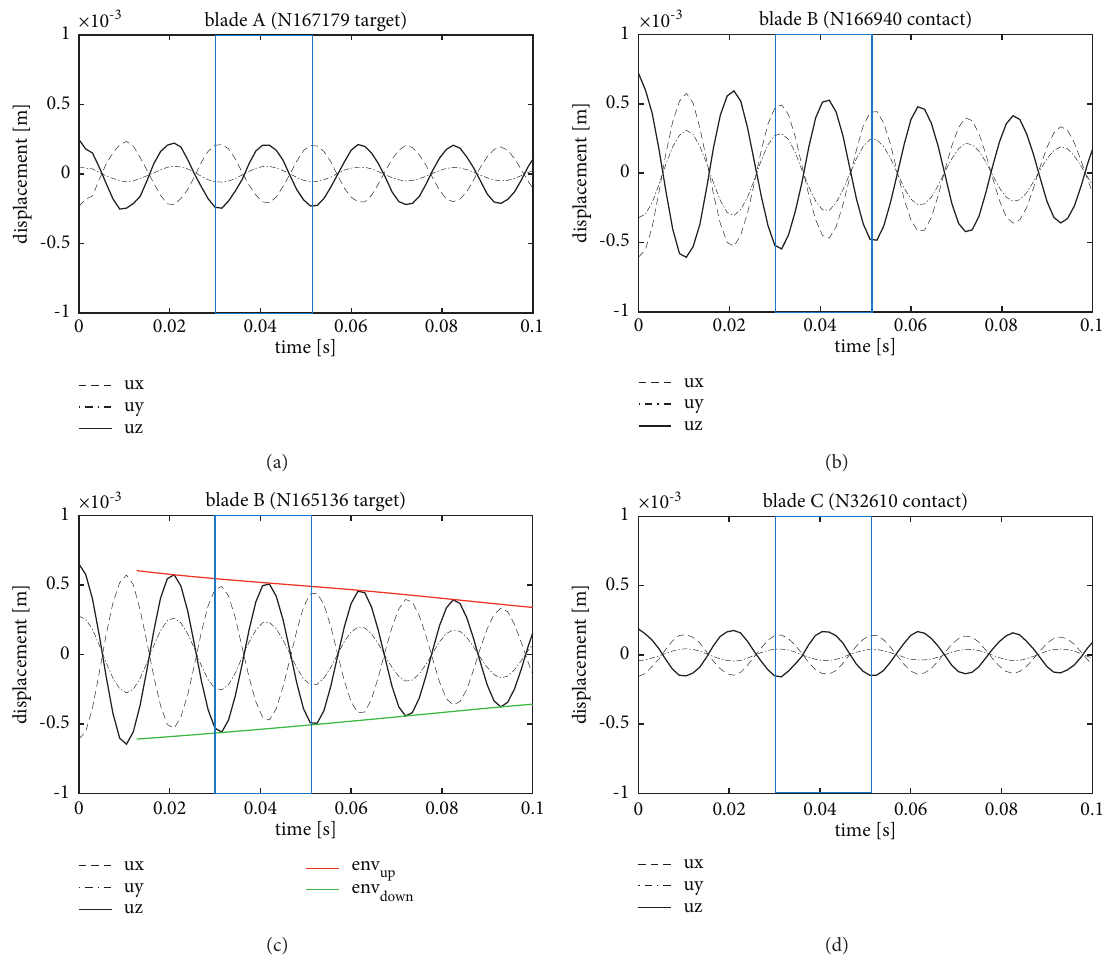
Figure 14: Time characteristics of displacements of blades BA, BB, and BC in nodes of target-contact pairs: (a)-(b) contact (A); (c)-(d) contact (B). Amplitude envelopes are denoted by red and green lines—6ND